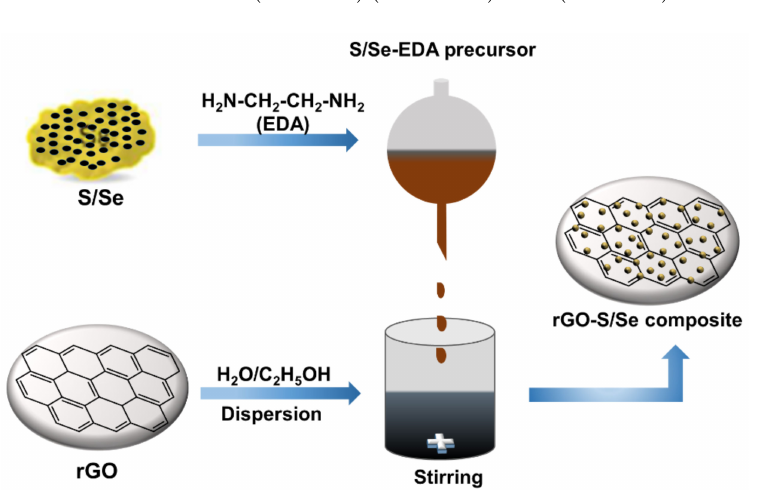
Figure 1. Schematic illustration of the synthetic procedure. Deposition of sulfur/selenium nanoparti- cles (S/Se NPs) on rGO via the sulfur-amine